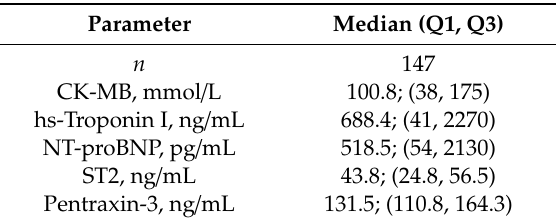
Table 2. Patients’ investigation